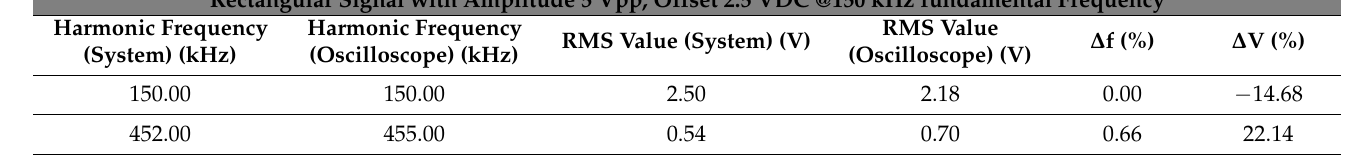
Table 6. Comparisons between the calibrated oscilloscope and the FPGA-based system measurements for rectangular signal with amplitude of 5 Vpp with 2.5 VDC offset value, for a signal’s fundamental frequency at 150 kHz.